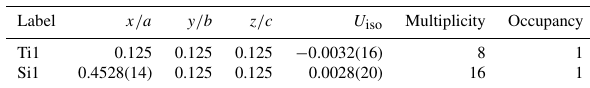
Figure 6. 3D reconstruction of electron diffraction data taken from zhiqinite (TiSi 2 ) at point no. 428 in foil no. 5358 (Fig. 3b). (a) View along 100 ∗ . Chess-board extinctions due to the F -centered lattice are evident. (b) View along 010 ∗ . (c) View along 001 ∗ . (d) View along 110 ∗ . Reflections hk 0 are present only for h + k = 4 n due to the occurrence of the d -glide plane (001). Cell edges are sketched in yellow. Red arrow indicates a ∗ direction, green arrow indicates b ∗ direction and blue vector indicates c ∗ direction. Table 5. Atomic coordinates for